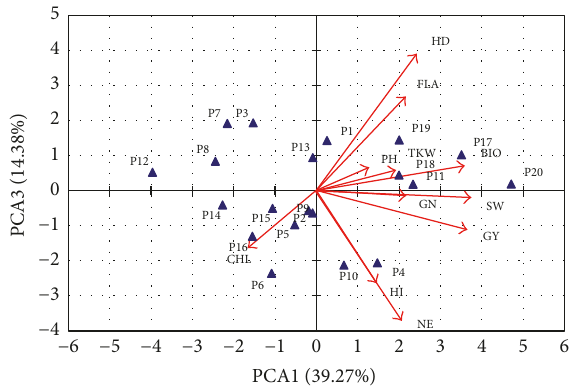
Figure 2: Principal Component Analysis (PCA) projections on axes 1 and 3, accounting for 53.65% of total variation, for 20 F 4 popula- tions of bread